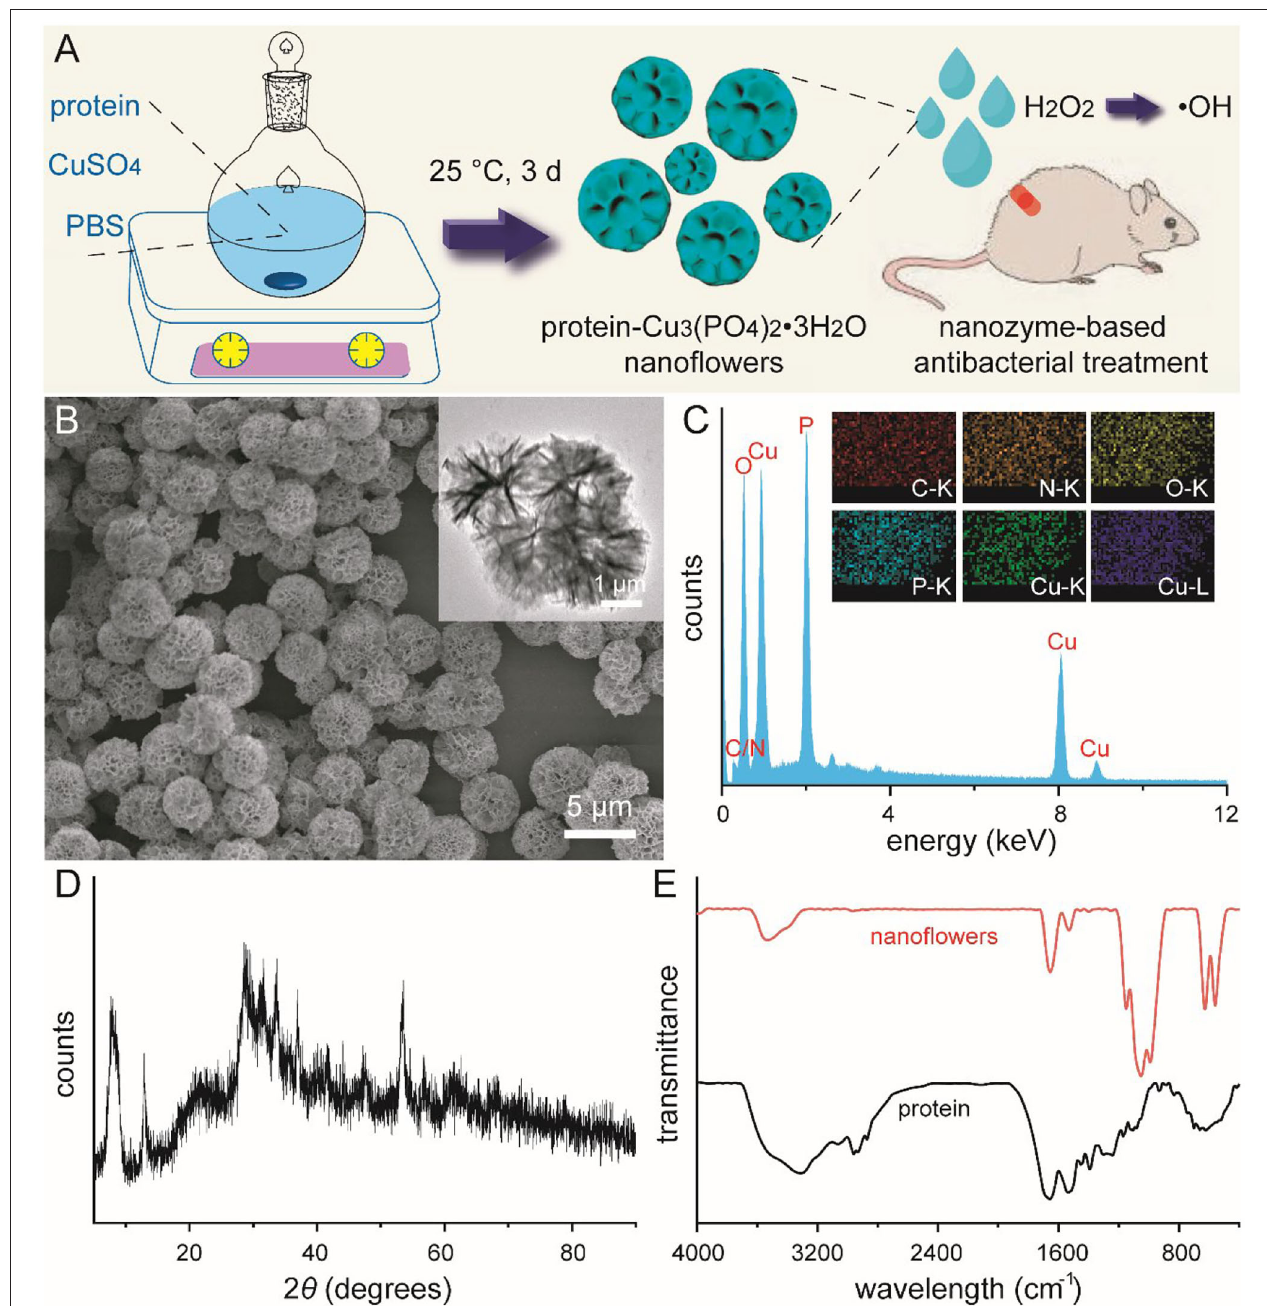
FIGURE 1 | Schematic illustration for the mild synthesis of protein-Cu 3 (PO 4 ) 2 · 3H 2 O nanoflowers and their usage in nanozyme-based antibacterial treatment (A) . SEM image (B) , EDS analysis (C) , and wide-angle XRD pattern (D) of nanoflowers. Inset of (B) : TEM image of nanoflowers. Inset of (C) : elemental mapping of nanoflowers. FT-IR spectrum of bovine serum albumin and nanoflowers (E)